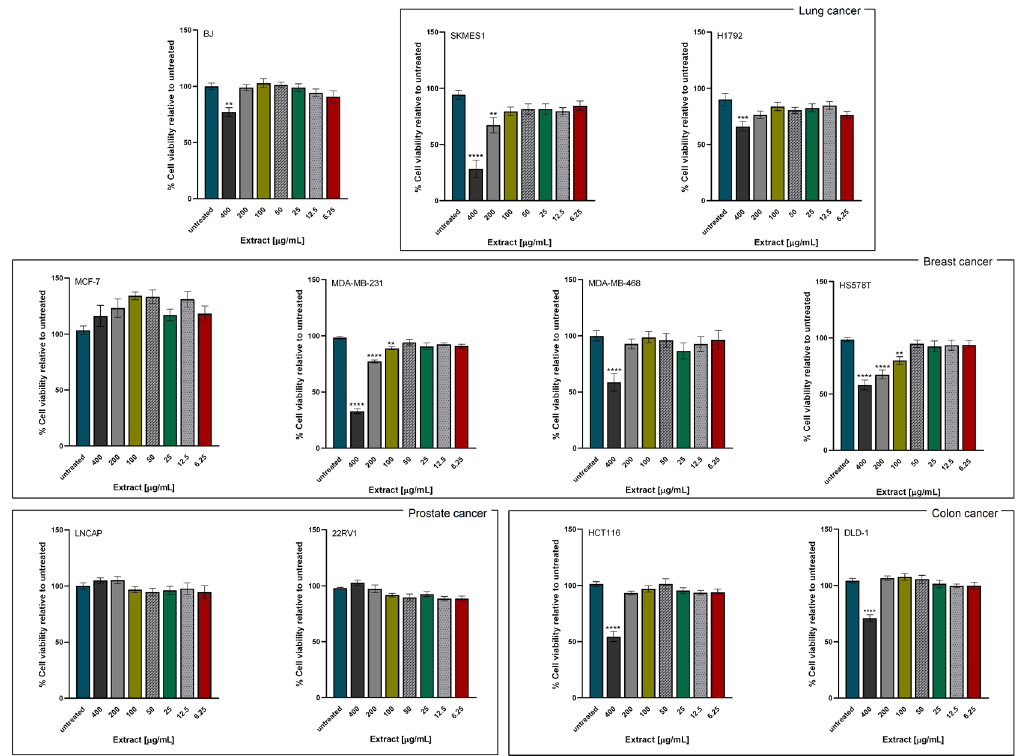
Figure 2. Effects of L. alpinum extract on cell viability. The panel of cell lines includes breast, prostate, lung and colon cancer representatives, as well as human fibroblast BJ. Cells were exposed to the indicated concentrations of L. alpinum extract for 48 h. Untreated cells (blank control) were exposed only to culture media while positive controls were represented by cells treated with 100% DMSO. Cell viabilities are expressed as percentage of control (set as 100%) and represented as mean ±SEM (n = 3). Data was analyzed by one-way ANOVA followed by Dunnett’s multiple-comparison test. The asterisks *, **, *** and **** indicate significant difference at p < 0.05, p < 0.01, p < 0.001 and p < 0.0001, respectively, compared to corresponding control.